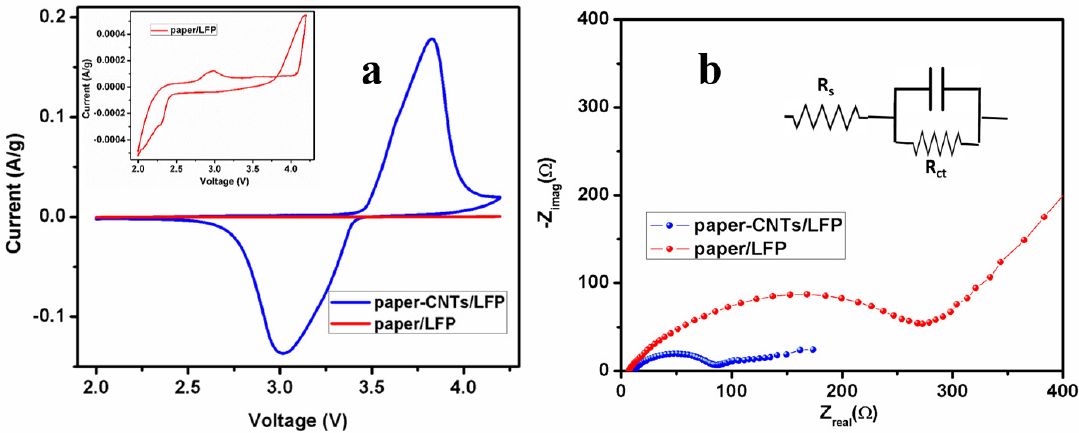
Figure 2: (a) Cyclic voltammograms (0.1 mV s −1 ) and (b) Nyquist plots for LiFePO 4 electrodes (with paper and paper-CNTs current collectors). The inset in Figure 2b shows the Randles circuit for single time-constant behavior observed in the Nyquist plot.